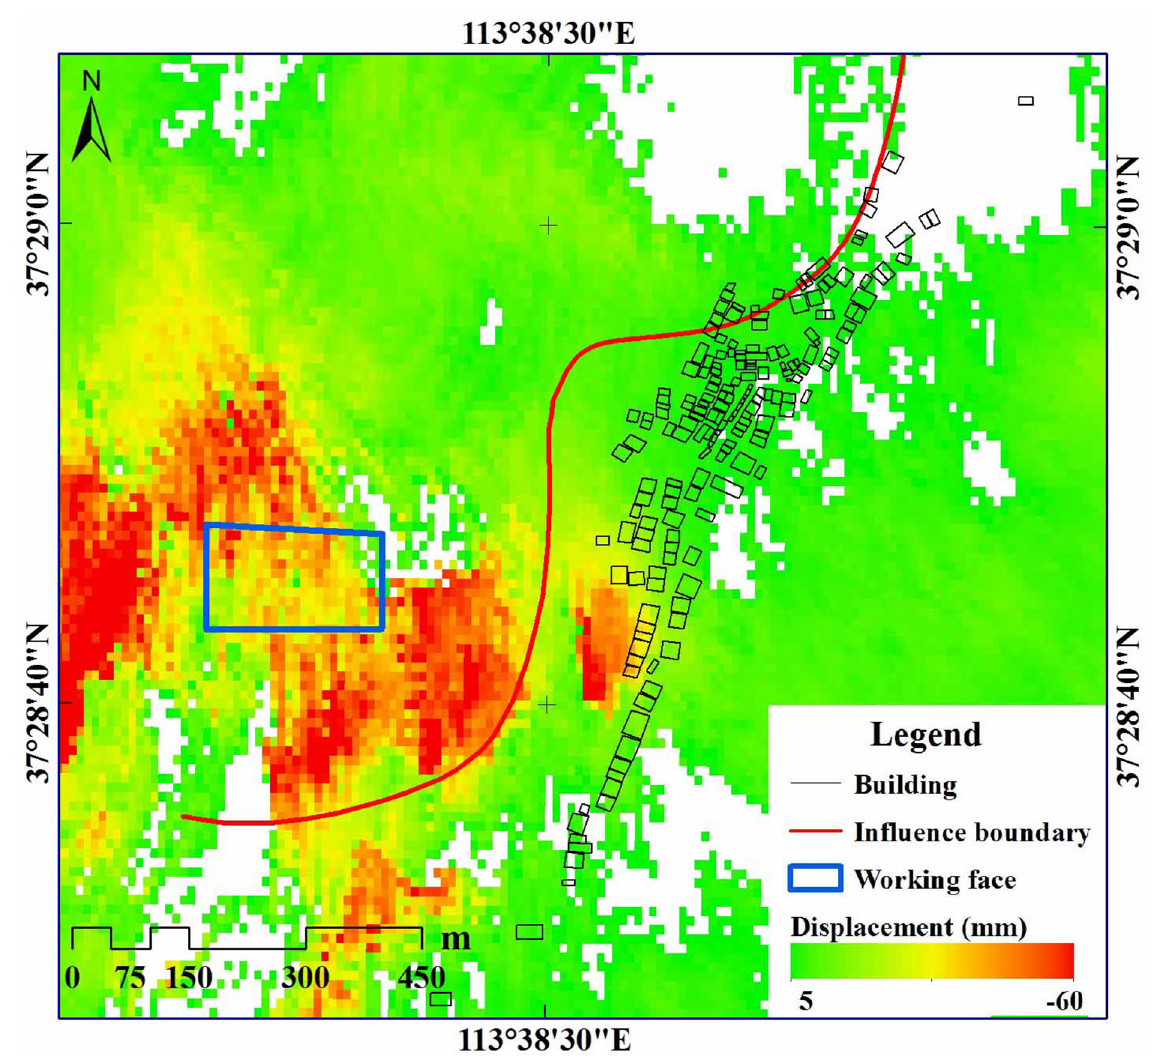
Fig 8. Monitored ground surface displacement using the conventional D-InSAR